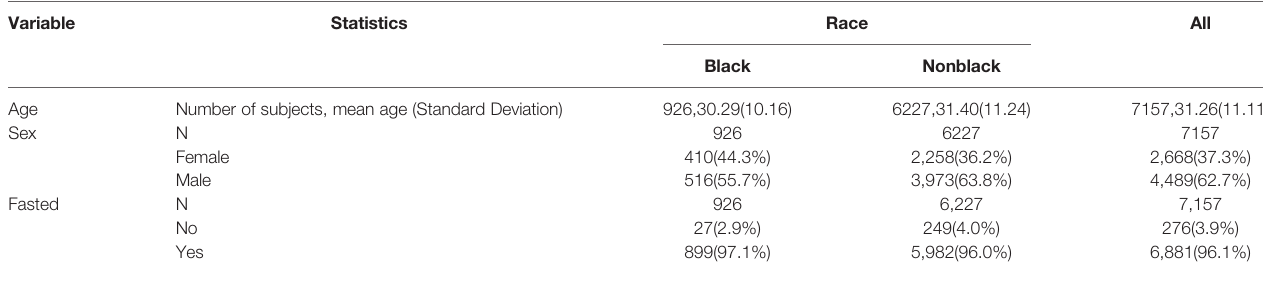
TABLE 2 | Baseline characteristics of